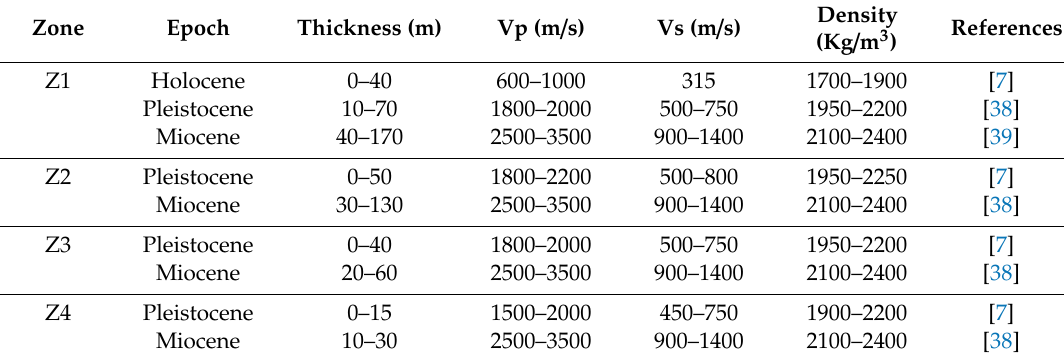
Table 1. Geological and geotechnical information for each zone of the study